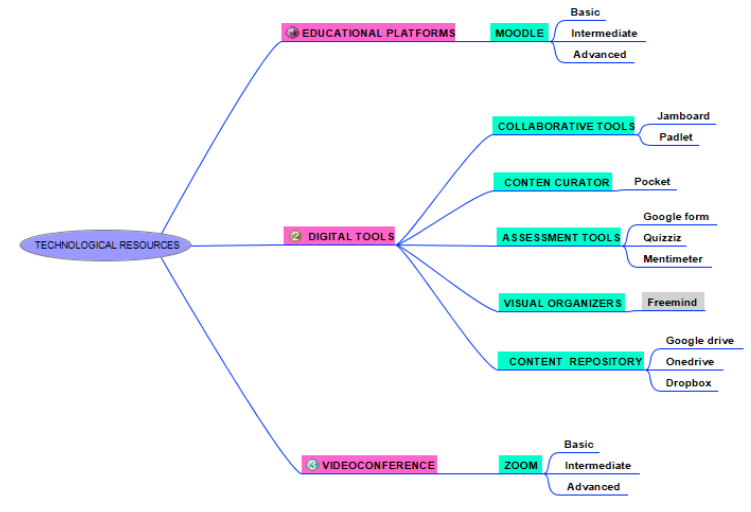
Fig. 2. Technological